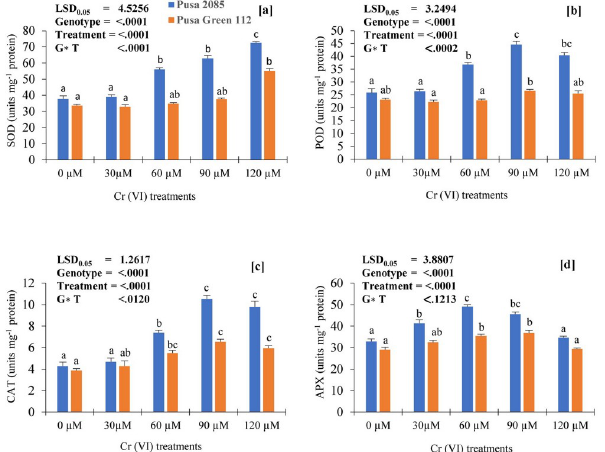
Fig 7. Effects of the various chromium (Cr) concentrations on the activities (units mg -1 protein) of antioxidative enzymes: Superoxide dismutase (SOD), Peroxidase (POD), Catalase (CAT), and Ascorbate Peroxidase (APX) in the leaves of two chickpea varieties (Pusa 2085 and Pusa Green 112) 21 days after treatment (DAT). Values are means ± standard errors from three independent experiments. Error bars with the same letters are not significantly different at p � 0.05. the reduction in seed yield per plant varied. The values for Pusa 2085 and Pusa Green 112 in the different Cr treatments were: 16.42 and 12.17 g at 60 μ M, 11.21 and 8.55 g at 90 μ M, and 5.59 and 2.78 g at 120 μ M Cr, respectively, in 2018–19 (Fig 8a and 8b). A similar trend was observed during 2019–20 but the reduction in seed yield per plant was higher compared to the previous year (Fig 8c and 8d). The Pusa 2085 genotype showed a lower reduction in pod and seed yield per plant than the Pusa Green 112 genotype. It showed a significantly greater